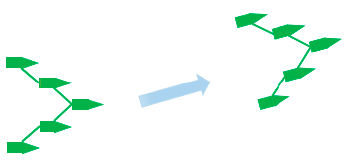
Figure 2. Formation generation.